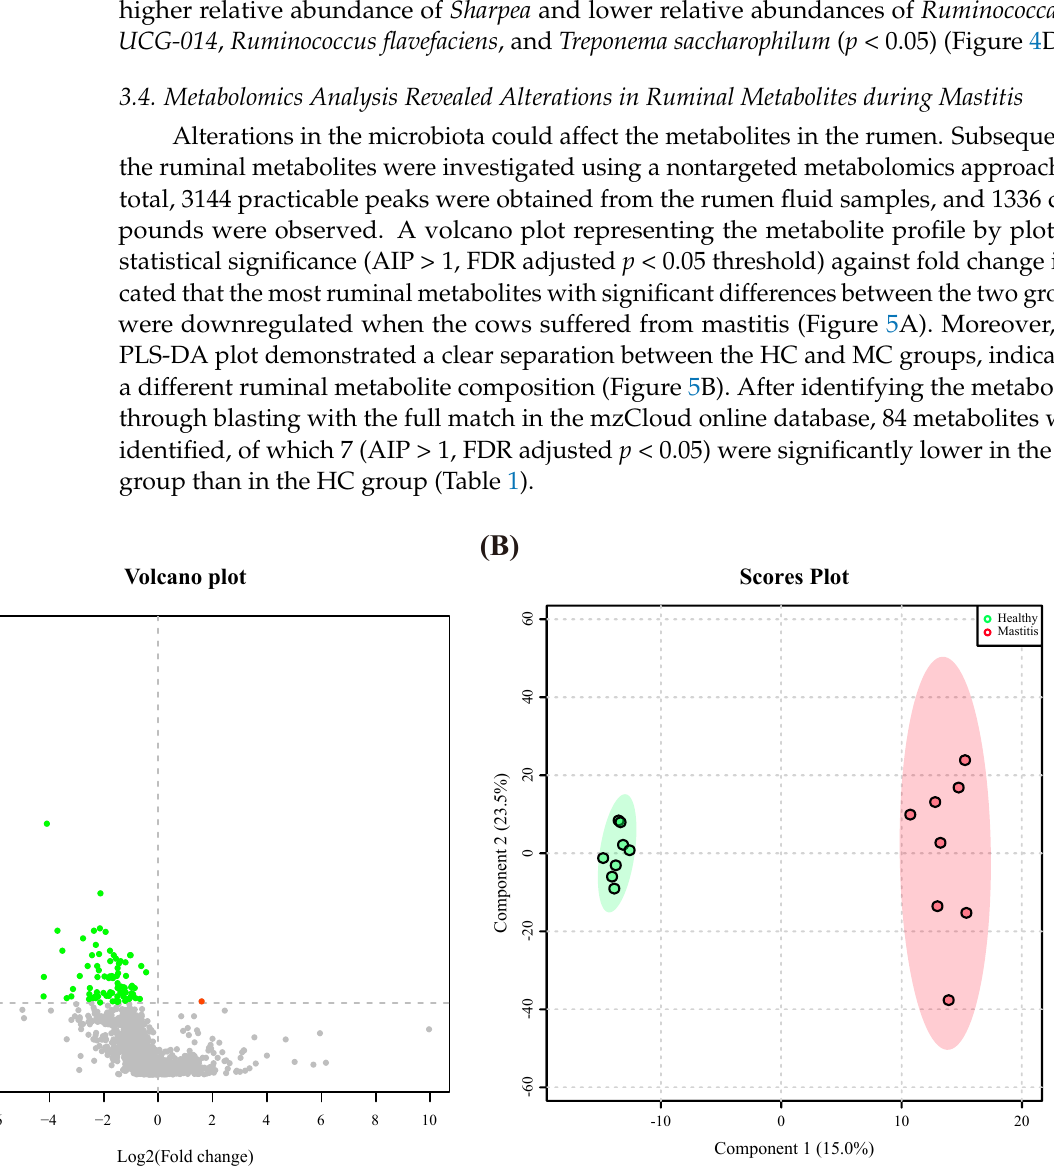
Figure 5. Different compositions of ruminal metabolites of the healthy and mastitic cows. ( A ) Volcano plot of 1336 com- pounds with log-transformed adjusted p values and fold change. The green and red dots indicate significantly higher metabolites in the healthy and mastitic groups, respectively. ( B ) Orthogonal partial least squares discriminant analysis (oPLS-DA) plot based on the 1336 compounds indicates significantly different metabolite compositions of the healthy and mastitic groups. Ellipses represent 95% confidence intervals for each group. Every dot represents a single individual